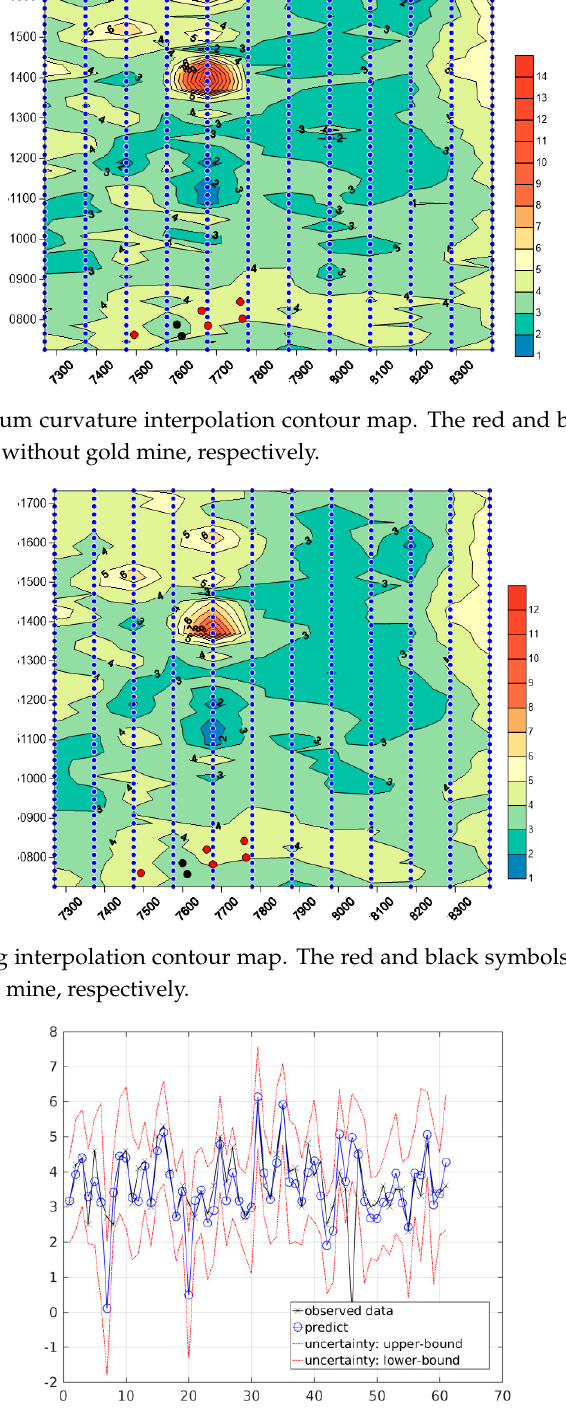
Figure 12. The uncertainty of the SPDE model-based prediction.